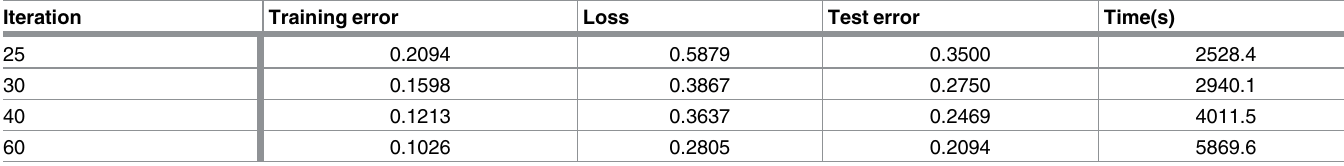
Table 2. Comparisons of loss and train errors based on different